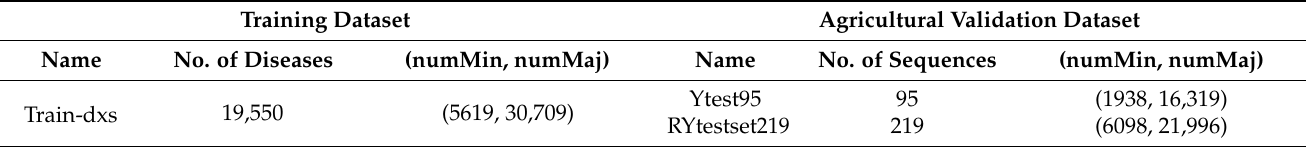
Table 1. Compositions of training datasets and aspects of the validation